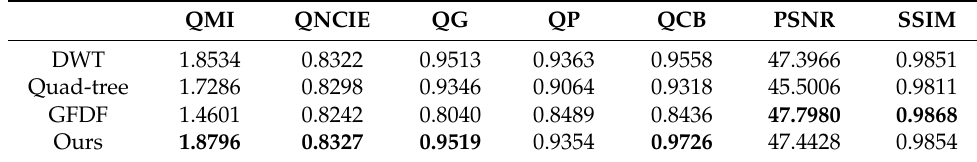
Figure 6. Details of “Bright cell” fused image results generated by different methods. ( a ) DWT, ( b ) quad-tree, ( c ) GFDF, and the ( d ) proposed method. Table 1. Quantitative results for evaluation metrics on the “Dark cell” image with four other methods.